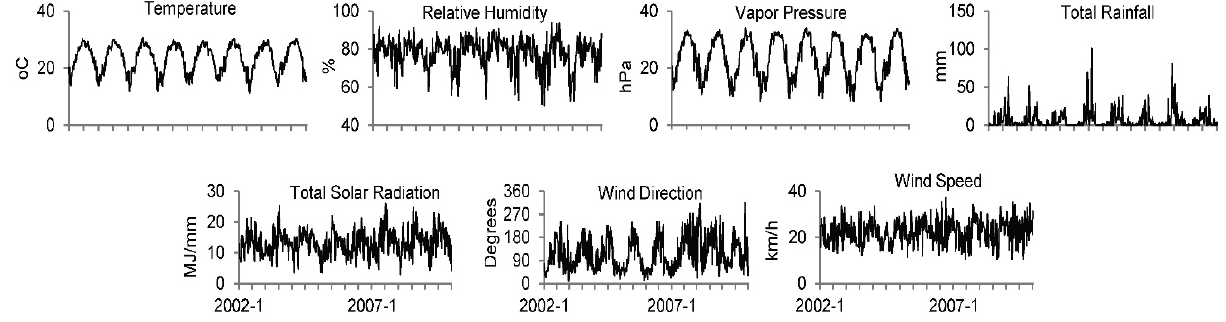
Figure 2. Weekly average of meteorological parameters from 2002 to 2009 in Hong